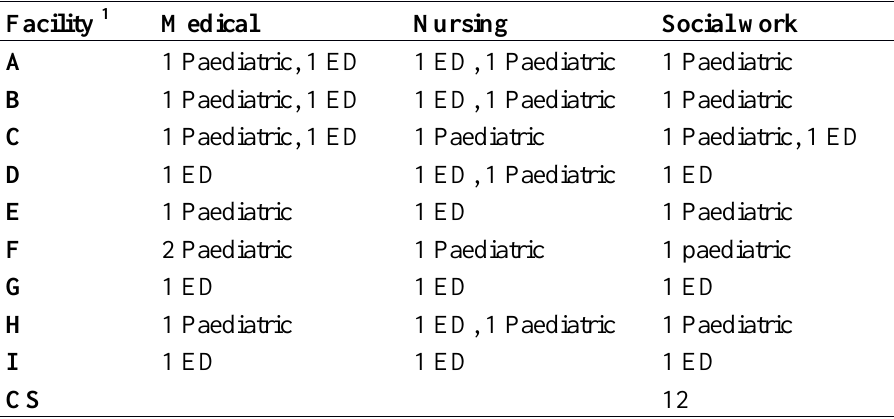
Table 2. Respondents to in-depth